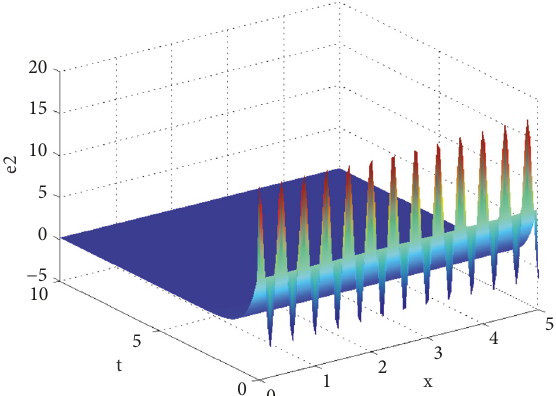
Figure 8: Timeevolution of thelinearsynchronizationcontrolerror 𝑒 2